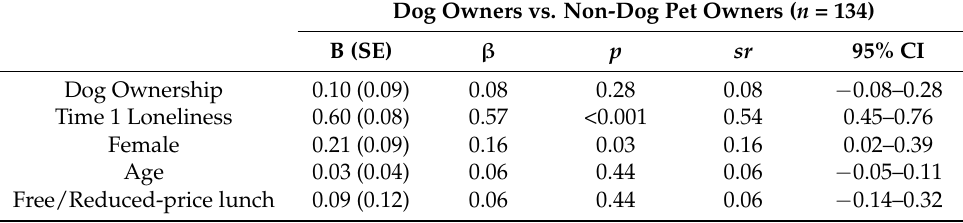
in loneliness from Time 1 to Time 2 (pre-COVID-19 to during COVID-19) compared to non-pet owners ( p = 0.008). Within pet owners, there was no significant difference between dog owners and non-dog pet owners ( p = 0.27; see Table 3 for full regression results) on change in loneliness. Although gender was a significant covariate, there were no significant interactions between gender and pet ownership ( β = 0.10, p = 0.39, 95% CI [ − 0.14, 0.35]) or